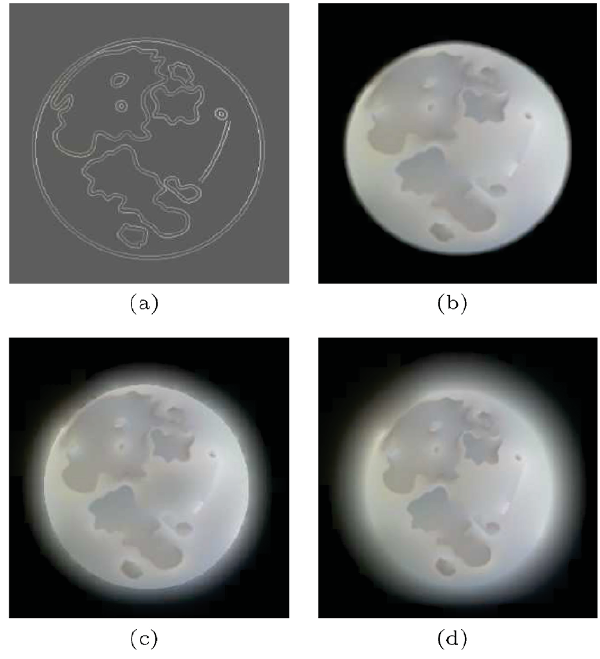
Fig. 5 Moon image: the emissivity of the outermost color source curve is controlled by setting different strength for the coefficients of pixels on its right adjacent curve, to generate halos of different intensity. (a) Color layer. (b)–(d) Strength coefficients of 0 . 0, 0 . 1, and 1 . 0 respectively.